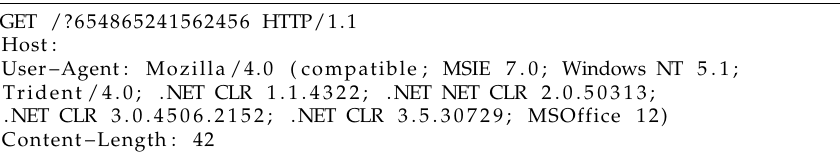
Listing 1. Default parameters of Slowloris header used by the proposed generator. GET /?654865241562456 HTTP/1.1 Host :